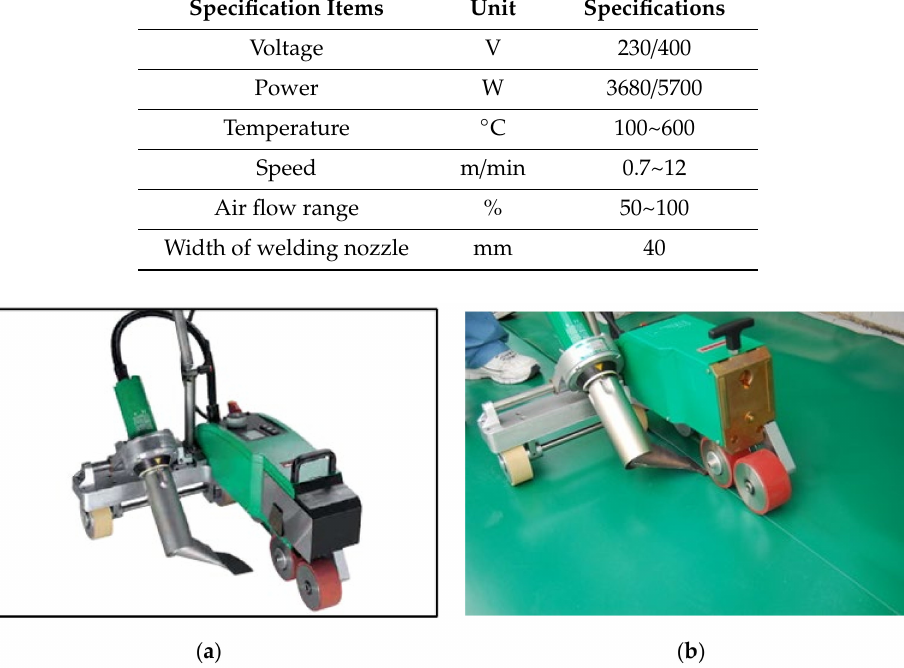
Figure 2. Automatic hot air welder and welding status: ( a ) automatic hot air welder; and ( b ) hot air welding status.